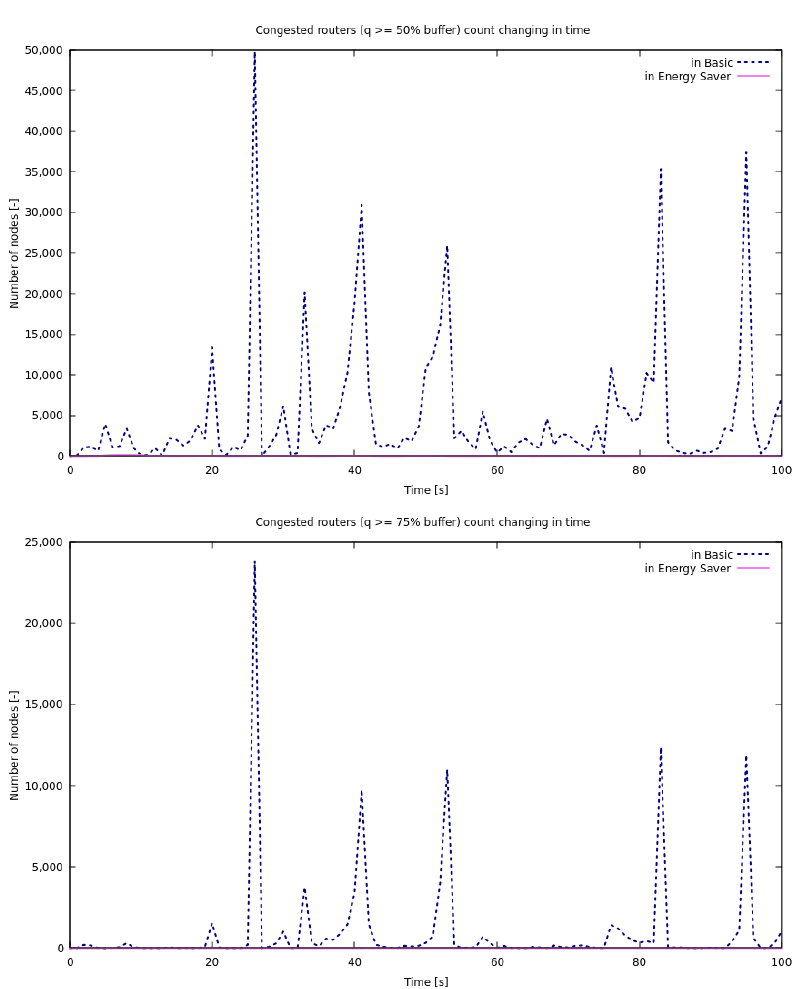
Figure 8. The number of routers having the current queue length (cid:62) 50% and 75% of the buffer for basic and energy-saving models. The curves for energy-saving mode are close to zero and practically invisible on the linear scale.